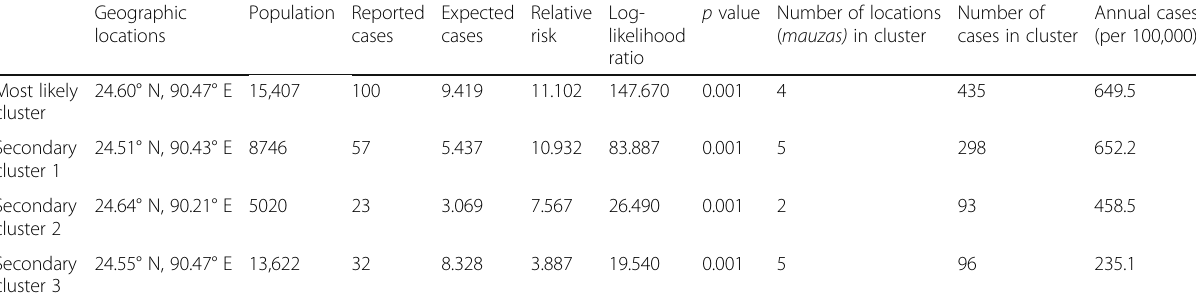
Table 2 Space-time clustering of VL in the study area Geographic Population Reported locations